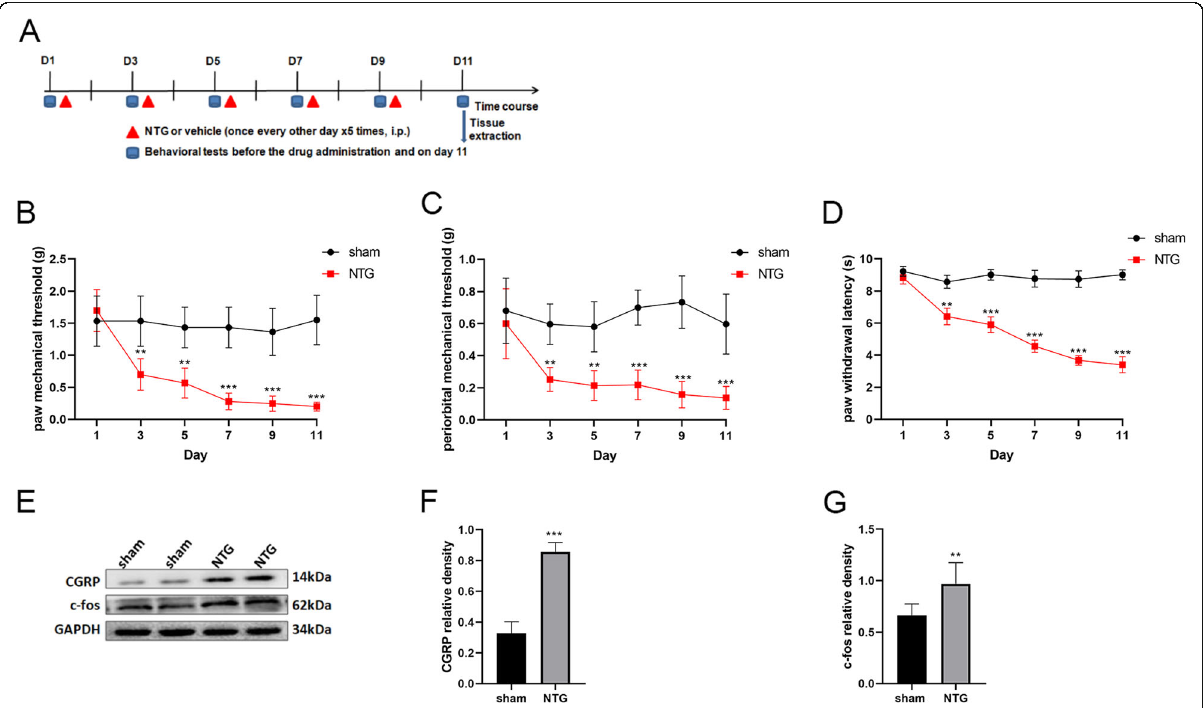
Fig. 1 Repeated NTG administration induced basal hyperalgesia and upregulated CGRP and c-fos protein expression. A Timeline for the first experiment, D:day. B , C and D The basal mechanical pain threshold of the hind paw ( B ) periorbital area ( C ) and the thermal pain threshold of the hind paw ( D ) were significantly decreased in the NTG group, compared with the sham group beginning on the third day. Two-way ANOVA with the Bonferroni post hoc test, n = 6/group, ** p < 0.01, *** p < 0.001. E, F, G The protein expression of CGRP and c-fos was assessed by WB assay and was markedly higher in the NTG group than in the sham group. Two-tailed Student ’ s t-test, n = 6/group, ** p < 0.01, *** p <